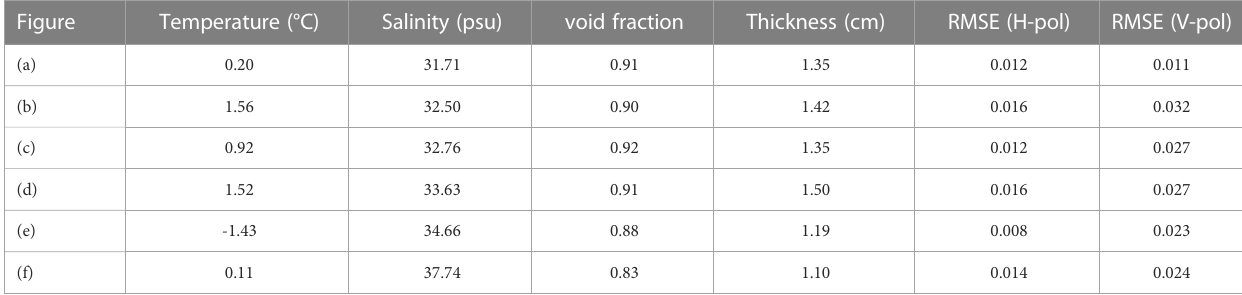
TABLE 2 Water properties of the measurements and RMS errors for the present model compared to Wei et al. experimental data. Figure Temperature (°C)